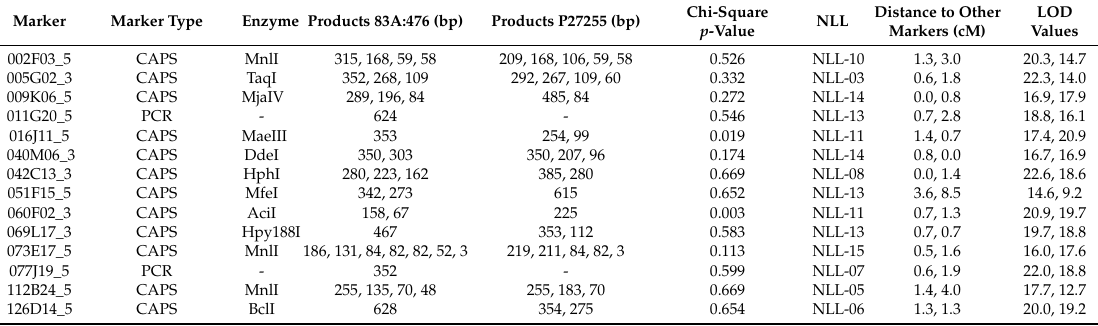
PCR - 352 - LOD: logarithm of